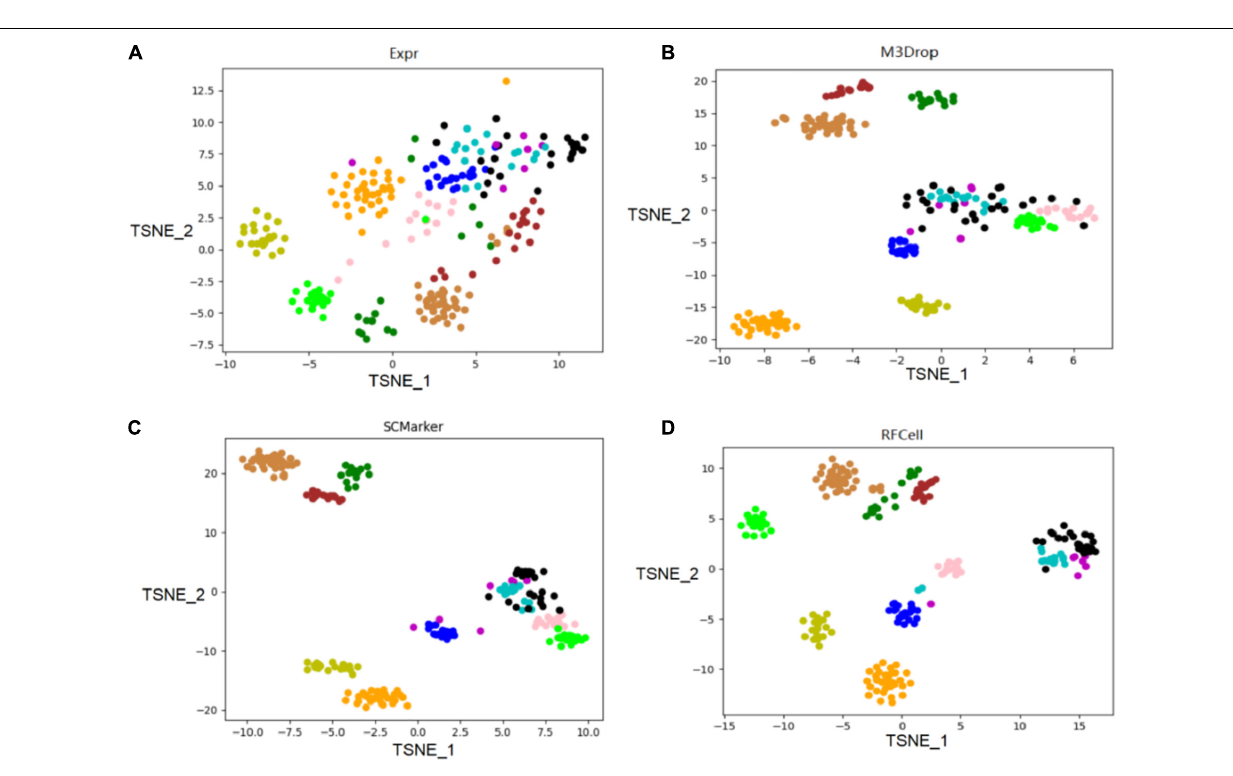
Frontiers in Genetics |